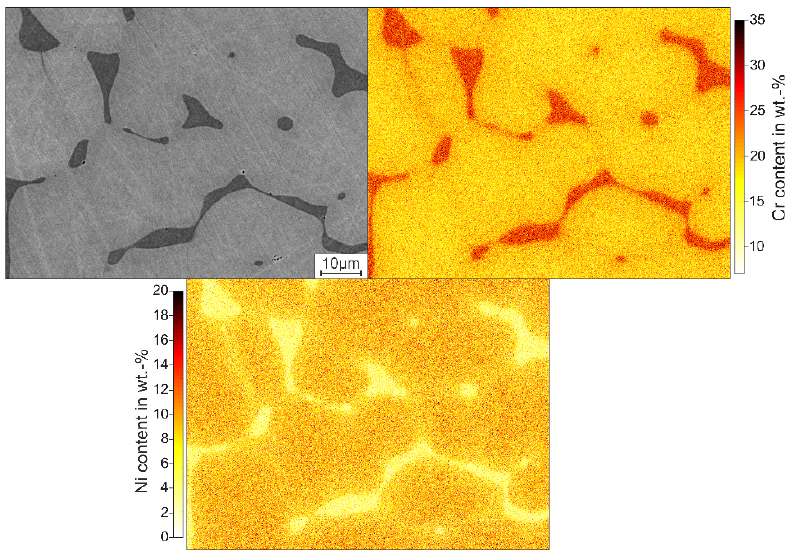
Figure 4. SEM-BSE micrograph and the local element concentrations of Cr and Ni in the X2CrNi18-9 steel.